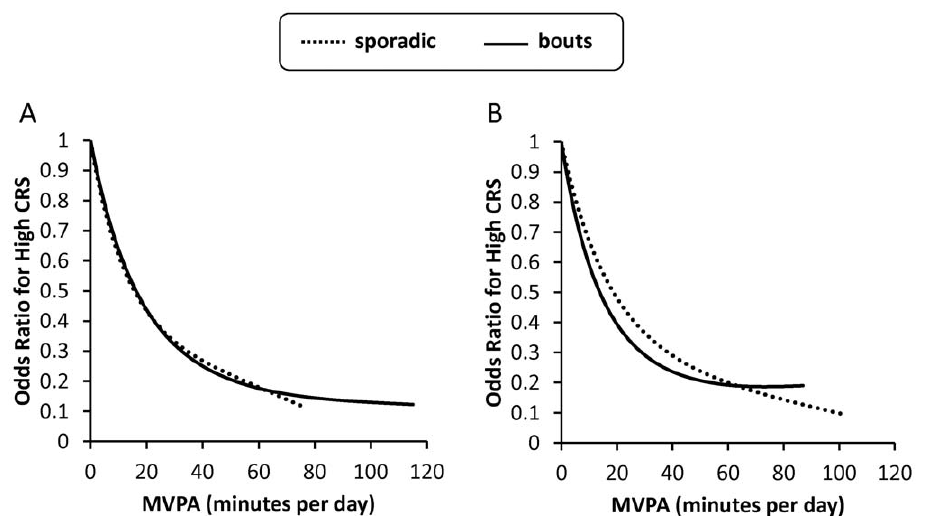
Figure 1. Association between sporadic and bouts of physical activity with high summary cardiometabolic risk factor scores . Odds ratio for a high cardiometabolic risk score (CRS) according to minutes per day of sporadic (dashed lines) and bouts (solid lines) of moderate-to- vigorous physical activity. In panel A (left), bouts were defined using a 5 minute threshold. In panel B (right), bouts were defined using a 10 minute threshold. Odds ratios were plotted from 0 minutes per day (referent) to values that corresponded to the 98 th percentile of the sample. Odds ratios were adjusted for sex, age, ethnicity, socioeconomic status, diet, smoking, and total accelerometer wear time.